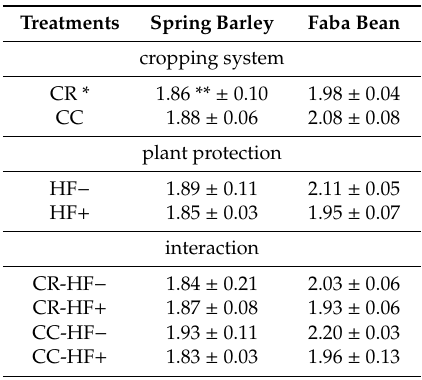
Table 3. Soil organic matter (SOM)